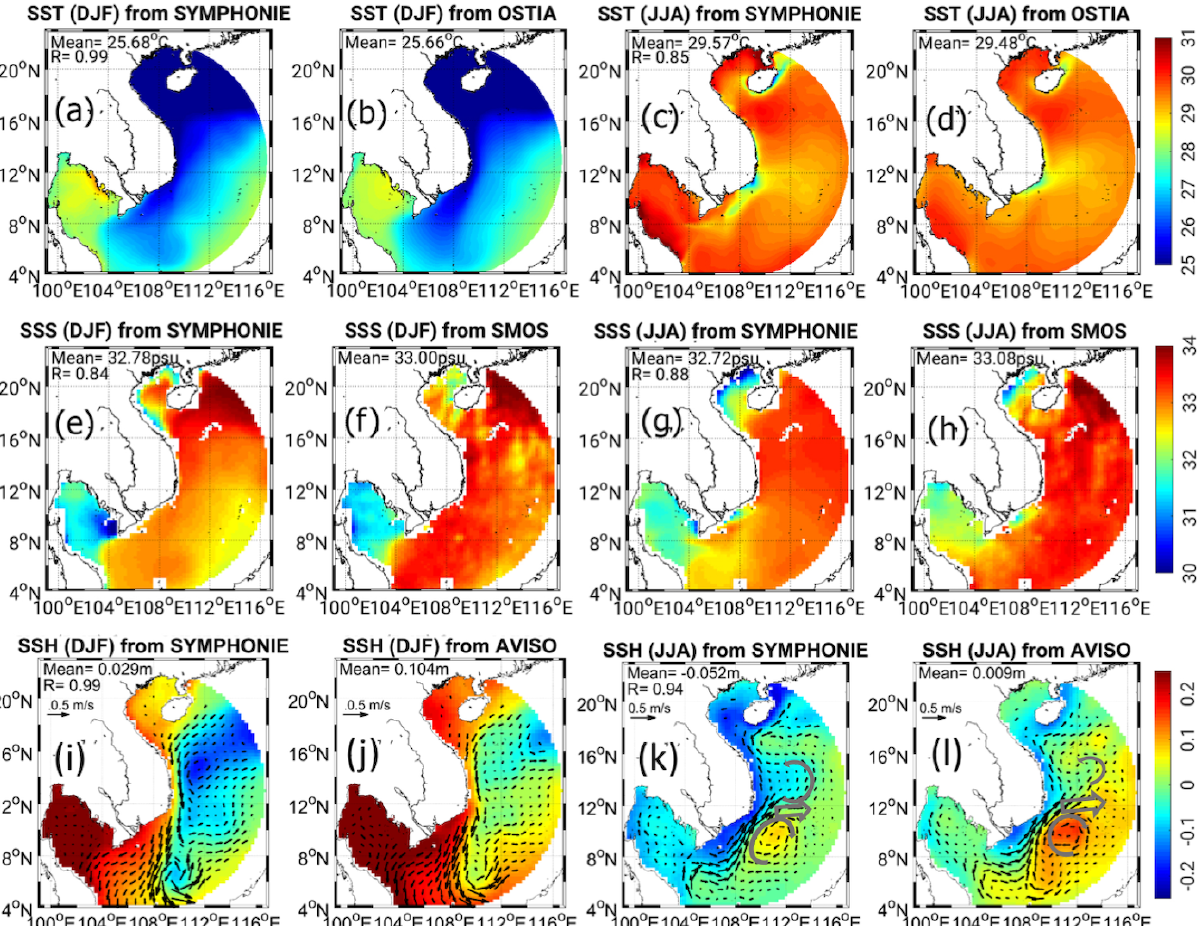
Figure 2. Spatial distribution of simulated and observed winter (DJF) and summer (JJA) climatological averages of SST ( a, b, c, d , ◦ C), SSS (e, f, g, h) , SSH (i, j, k, l, m) , and total surface geostrophic current (ms − 1 ) and spatial correlation coefficient R (here the p value is always smaller than 0.01). Gray arrows on panels (k) – (l) highlight the summer ACC dipole and eastward